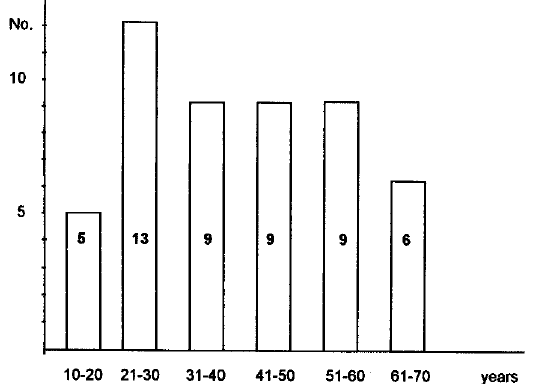
Fig. 1. Age distribution of 51 patients with pelvic chondrosar- coma.